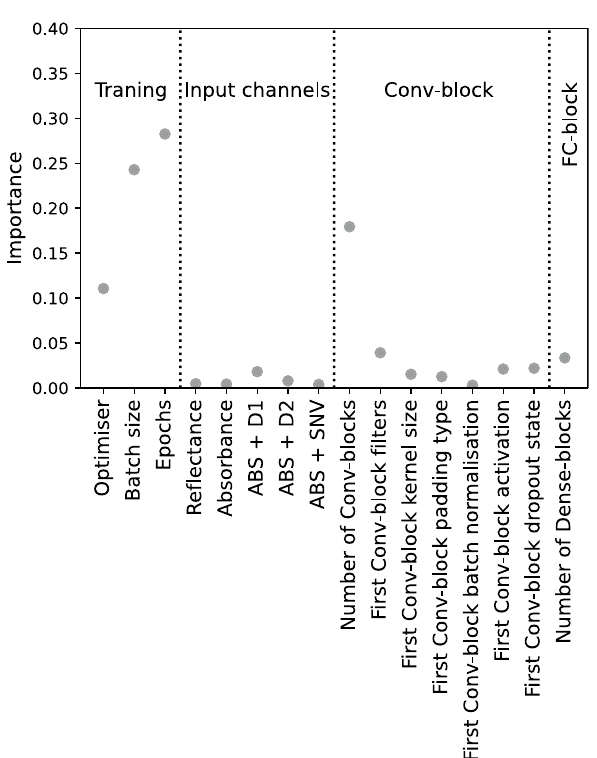
Figure 3. Hyperparameter importance based on the optimisation history. Hyperparameters are classified into training-related, input channels, Conv-block, and